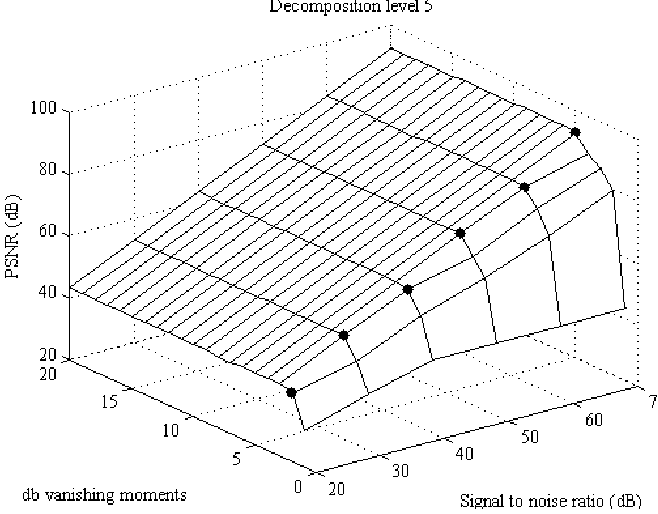
Figure 5. Noise reduction as a function of wavelet vanishing moments and SNR for 5 th decomposition level.